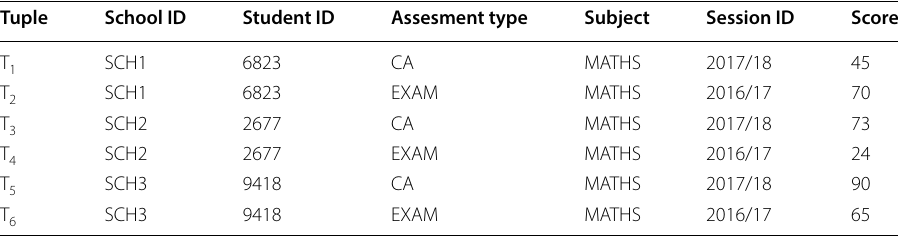
Table 1 Relation (assessmentscores) Tuple